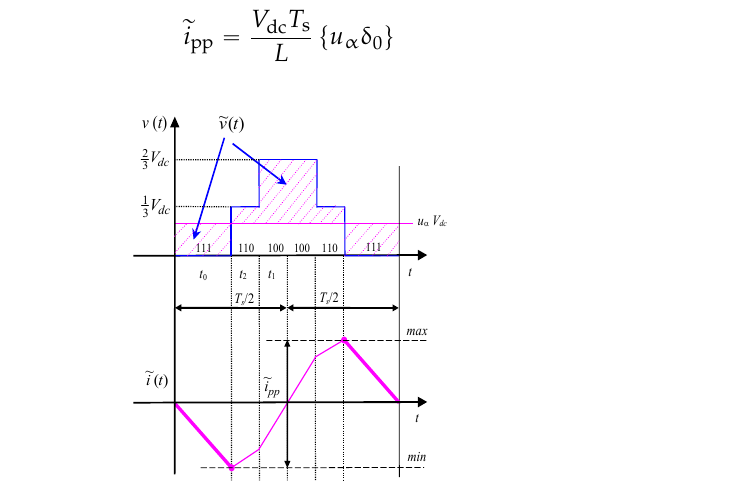
Figure 9. Output voltage and current ripple for DPWM+ technique in one switching period (sector I, 0 ≤ u α ≤ 1/3).